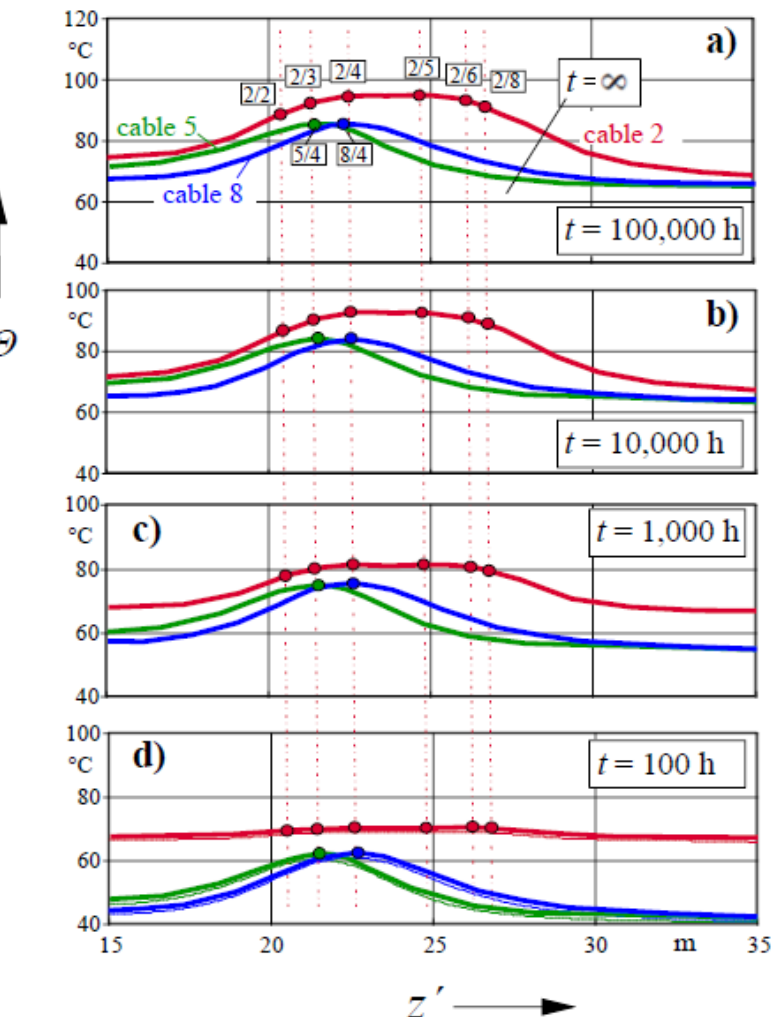
Figure 16. Conductor temperatures of the middle cables 2, 5 and 8 Figure 12: in system I (cable 2) with a steady load of 1600 A, whereas in systems II (cable 5) and III (cable 8) with load steps of 1600 A at t = 0 in cables 4…9; temperature distributions for ( a ) t = 100 h, ( b ) 1000 h, ( c ) 10,000 h, ( d ) 100,000 h; for explanations of the special points: see Figure 12 and Table 1.